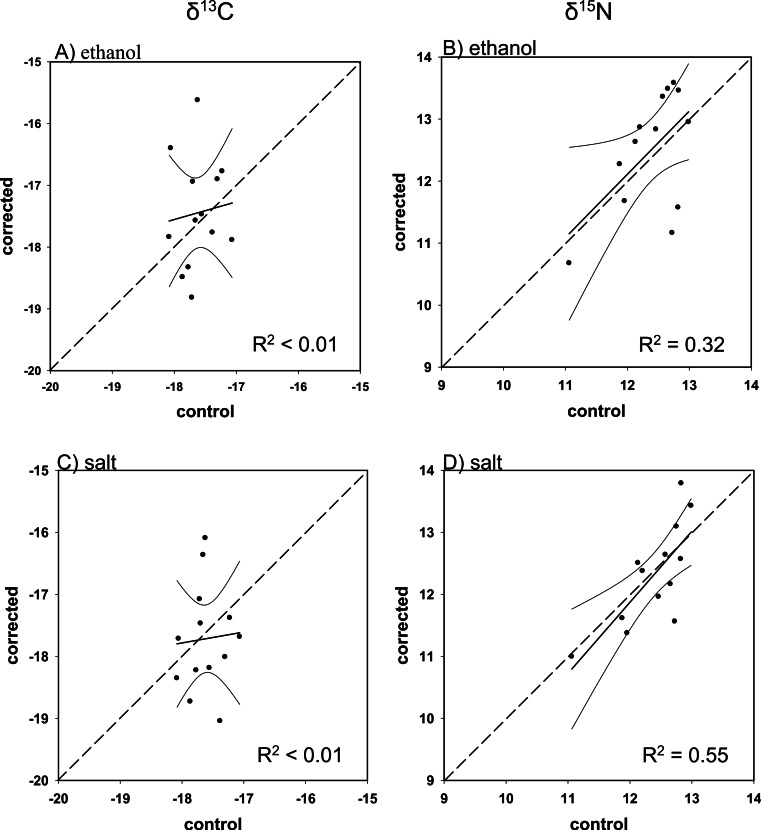
Mass balance corrected values against control values for M. phenax.The 1:1 line (hashed), predicted (solid), and 95% confidence intervals are given for (A) ethanol δ13C, (B) ethanol δ15N, (C) salt δ13C, and (D) salt δ15N.